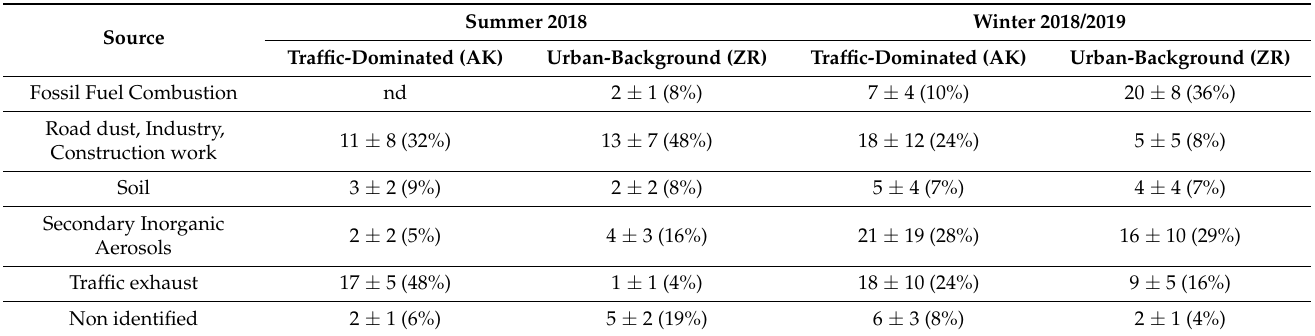
Figure 6. Monthly contributions of the sources to PM 10 mass at traffic-dominated (AK) ( A ) and urban-background (ZR) ( B ) stations identified through PMF modelling. Table 4. Contribution of different sources to PM 10 mass identified through PMF modelling during summer 2018 and winter 2018/2019 (in µ g/m 3 ± St.dev. and in